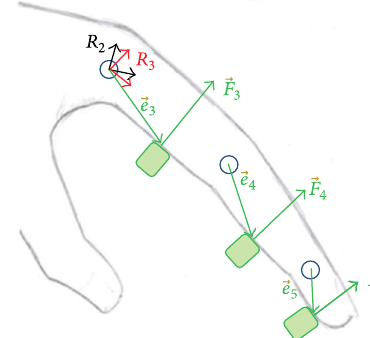
Figure 5: Contact